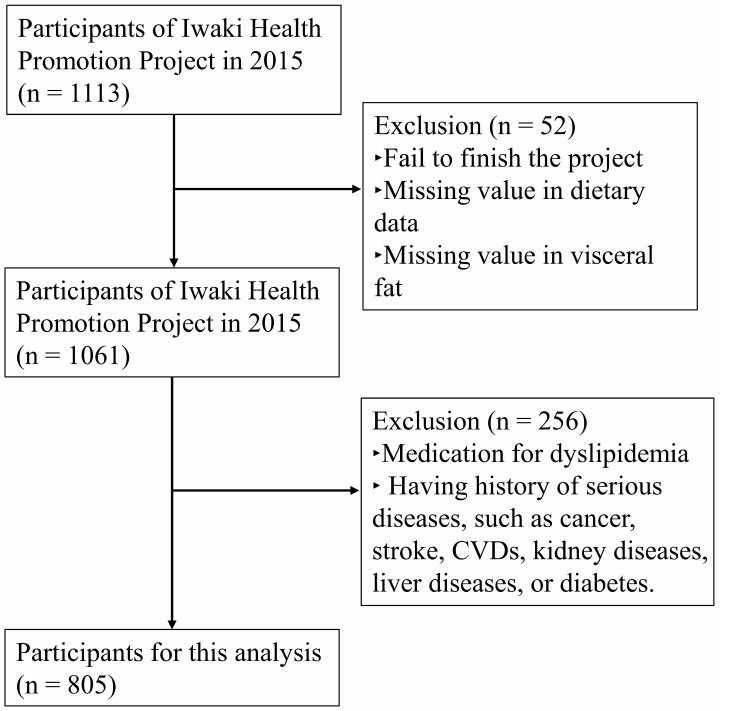
Figure 1. Flowchart for the recruitment of